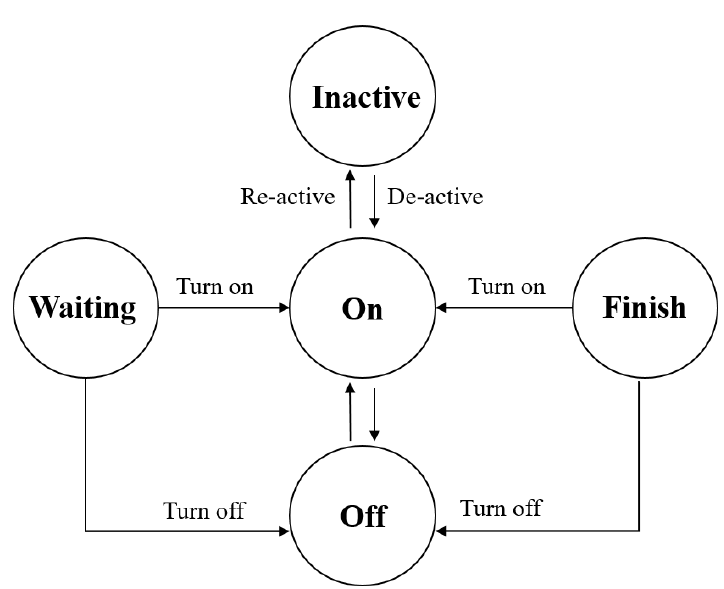
Figure 6. Status actions of connected